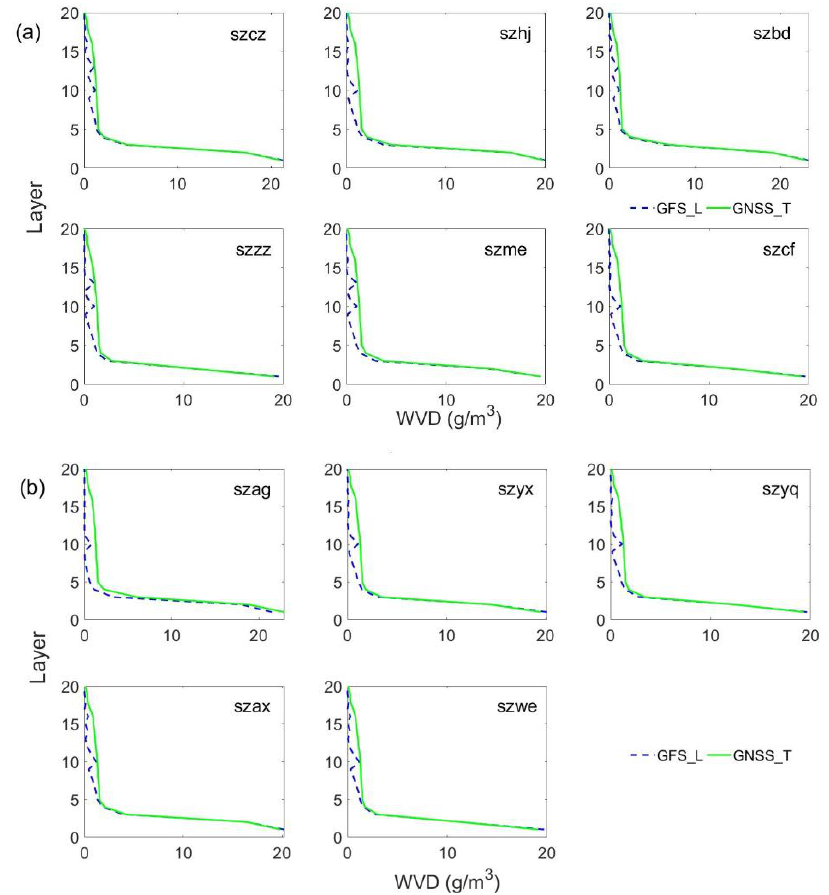
Figure 8. ( a ) Comparison of GNSS_T and GFS_L between 20 layers at following stations: szcz, szhj, szbd, szzz, szme, szcf. ( b ) Comparison of GNSS_T and GFS_L between 20 layers at following stations: szag, szyx, szyq, szax, szwe.